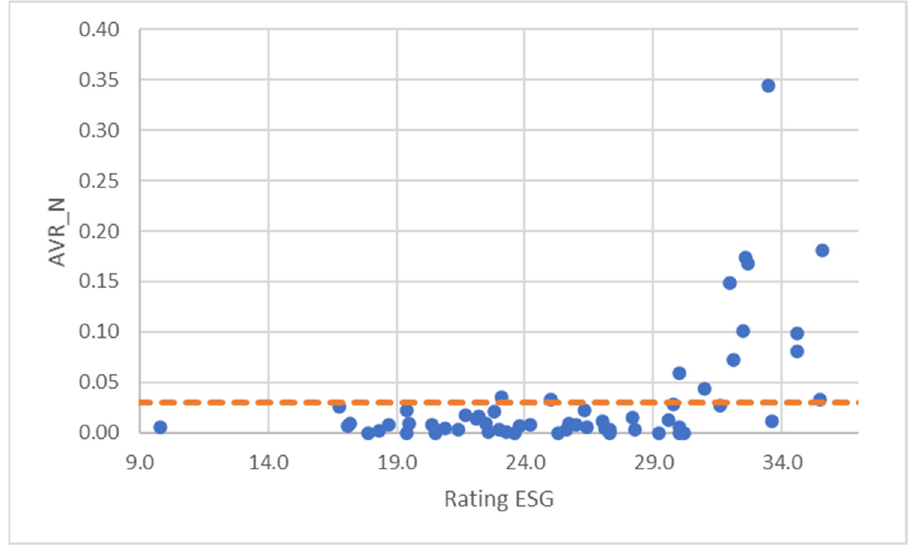
Figure 2. Relation between ESG ratings ( X -axis) and AVR_N ( Y -axis). The horizontal line represents the cut-off value translated into dummy variable AVR_N_cut-off.